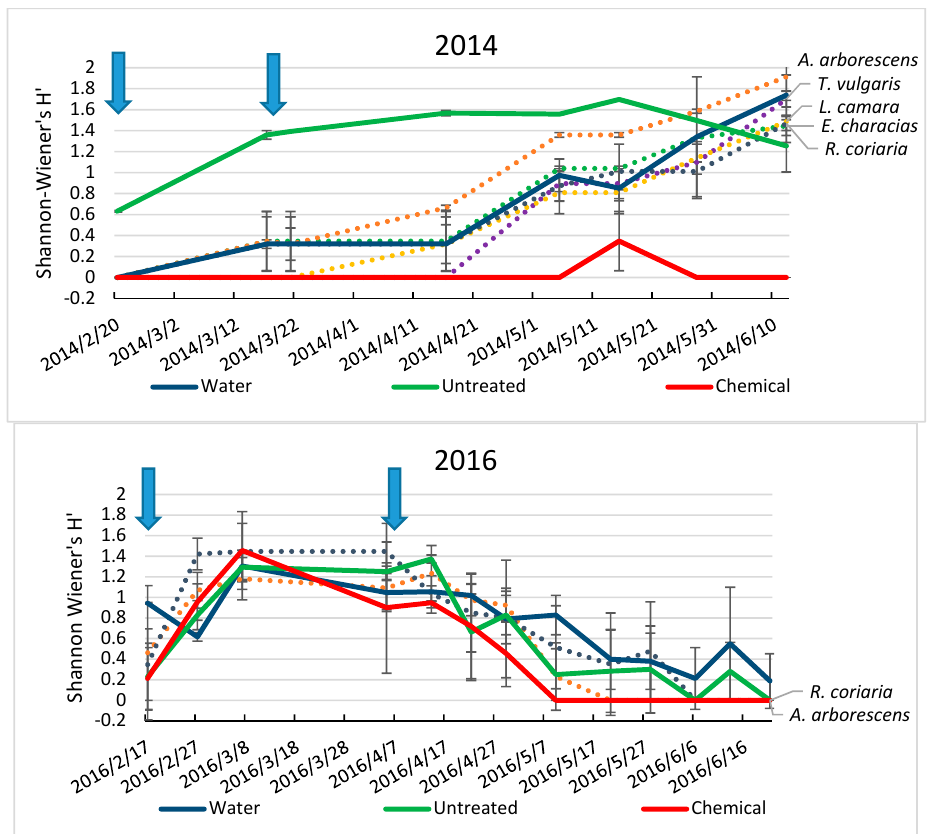
Figure 7. Species diversity (Shannon-Wiener index, H’) in 2014 and 2016 in durum wheat treated with five (2014) and two (2016) plant water extracts, compared with an untreated control (green line), a chemical herbicide (red line) and a control with only water (blue line). Each value is the mean of three repetitions ± standard deviation. Arrows indicate the date of treatments.